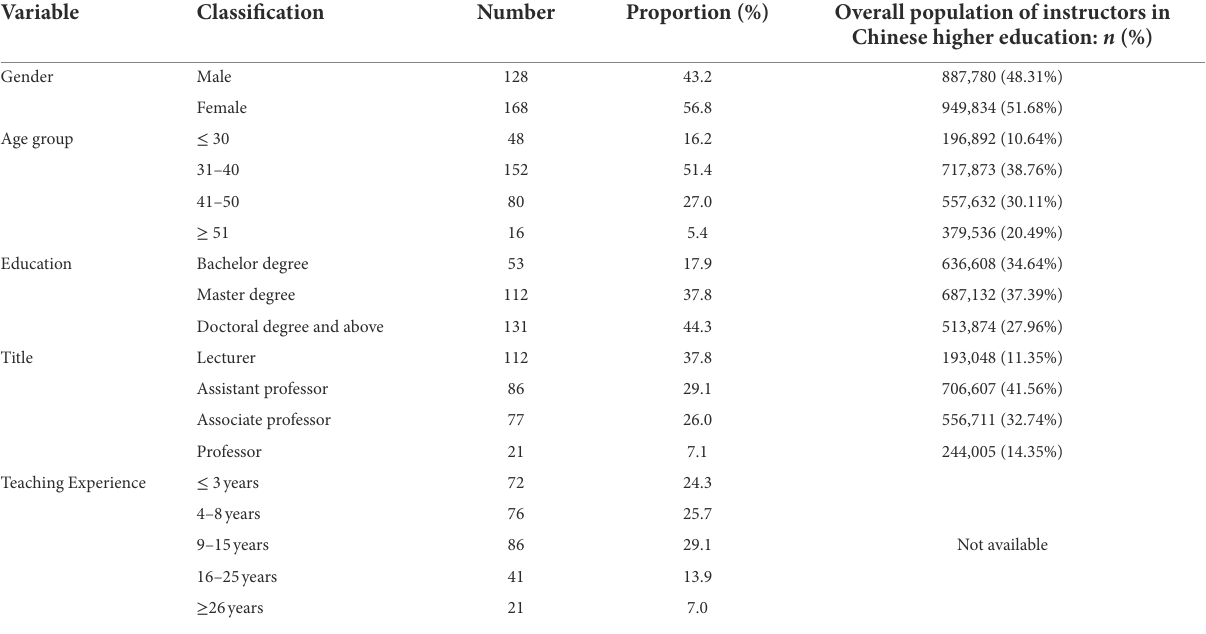
TABLE 2 Demographic data from the